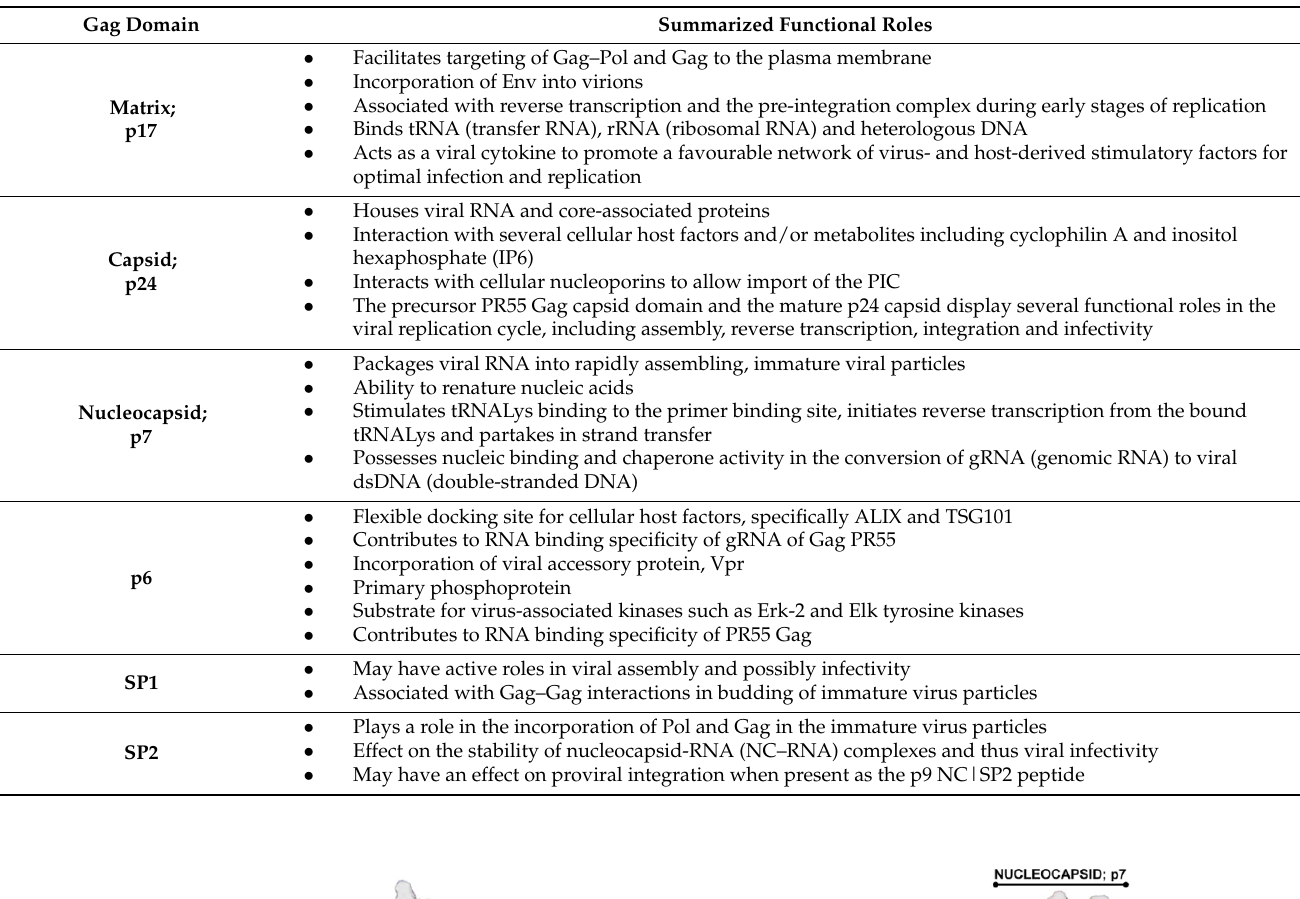
Table 1. Summary of known functional roles employed by the HIV-1 Gag domains in viral replication and infectivity.